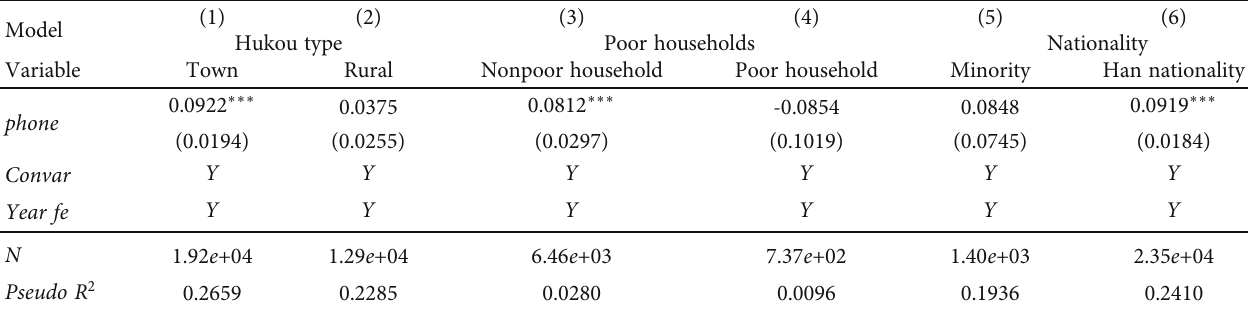
Table 9: Heterogeneity test